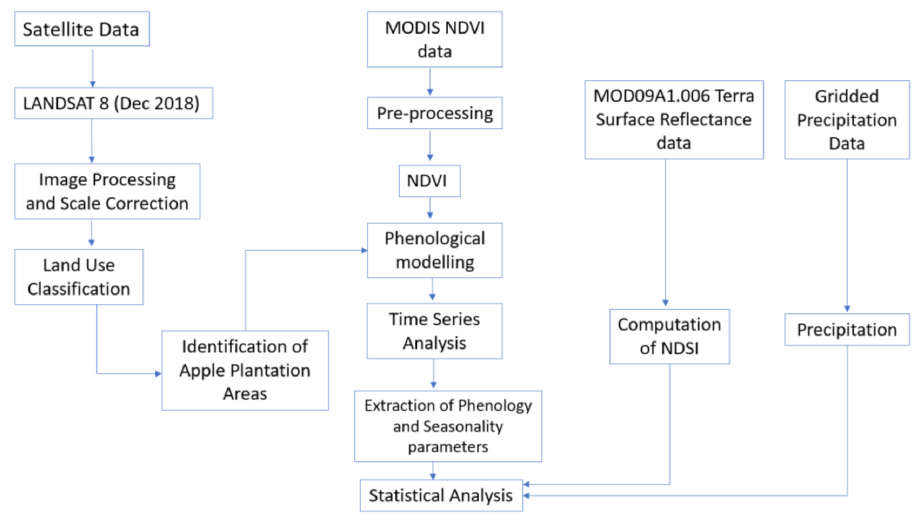
Figure 2. Data and methods used for the